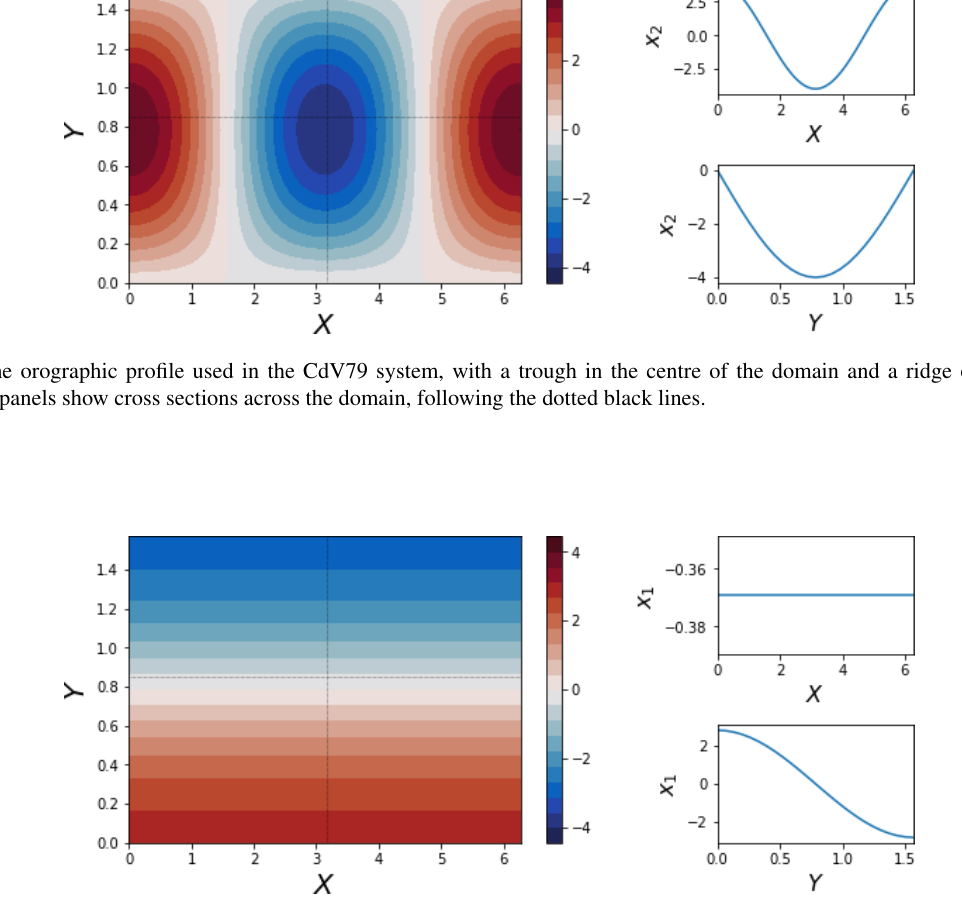
Figure A3. The background state in the Crommelin 1904 formulation of the CdV79 system. It is zonally symmetric and represents the impact of the meridional temperature gradient. Again, sub-panels show cross sections across the domain, following the dotted black lines.